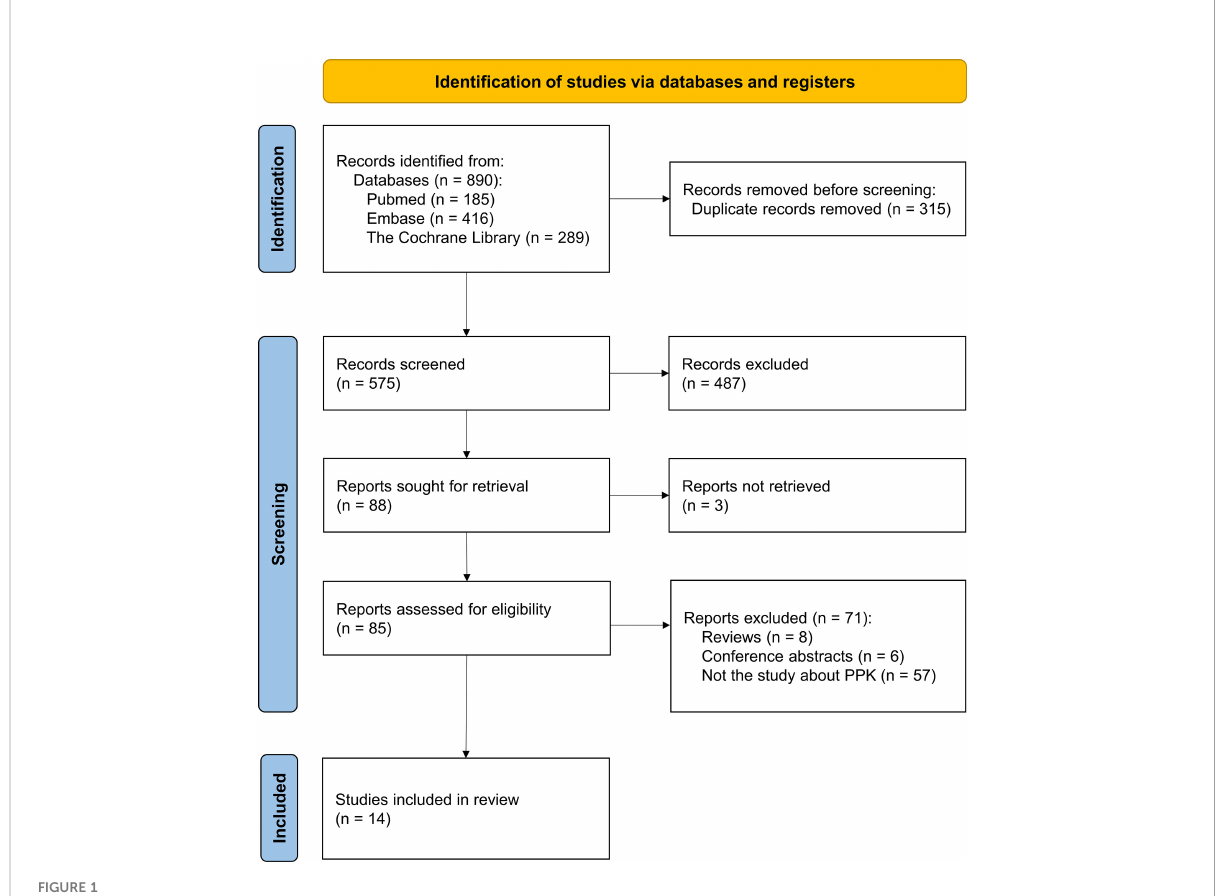
FIGURE 1 The PRISMA fl ow